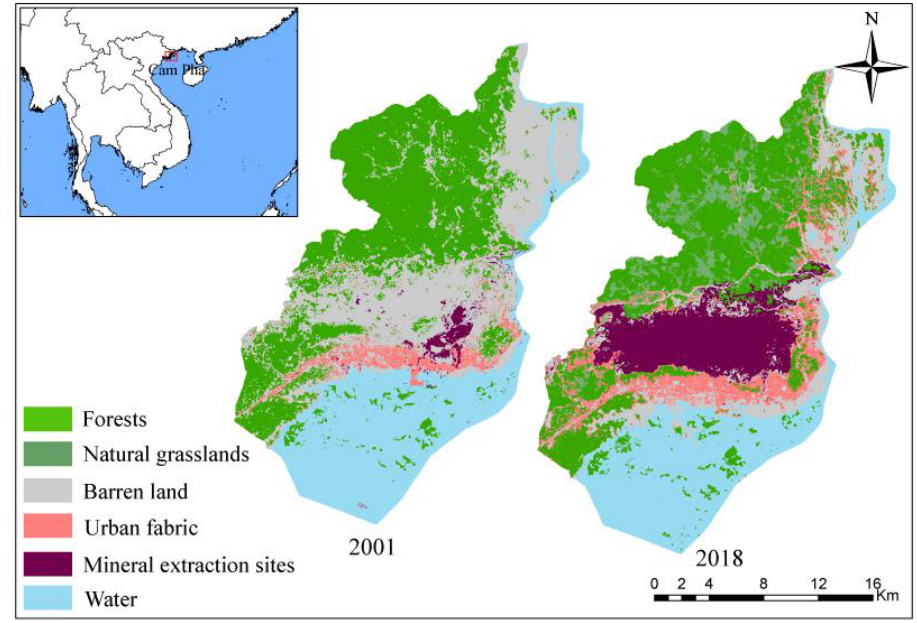
Figure 12. Land cover/land use patterns in the Cam Pha area, Vietnam during